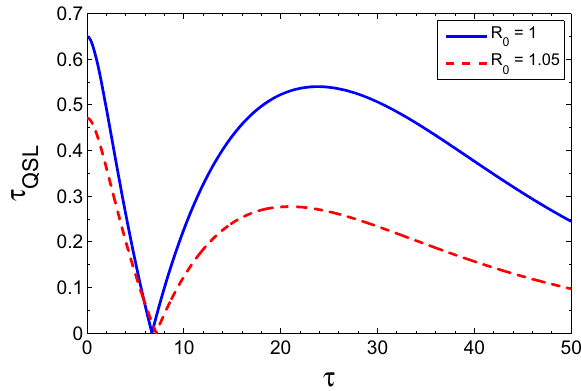
Fig. 3 The QSL-time for the damped Jaynes-Cummings model as a function of the initial time parameter τ . The coupling is weak i.e. γ 0 = 0 . 1 λ and Ω = 10